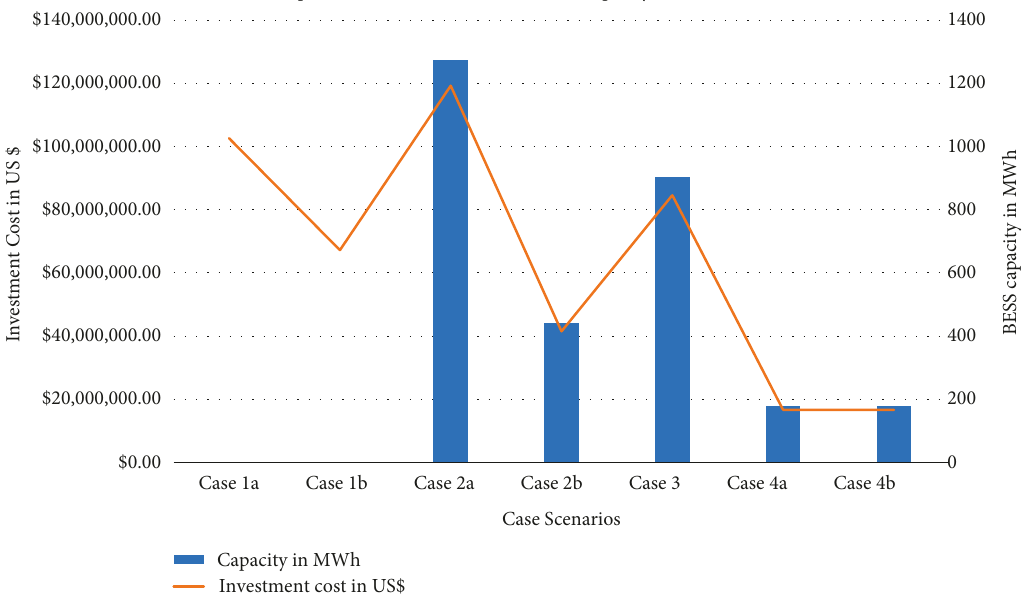
Figure 21: Comparison of BESS capacity and investment